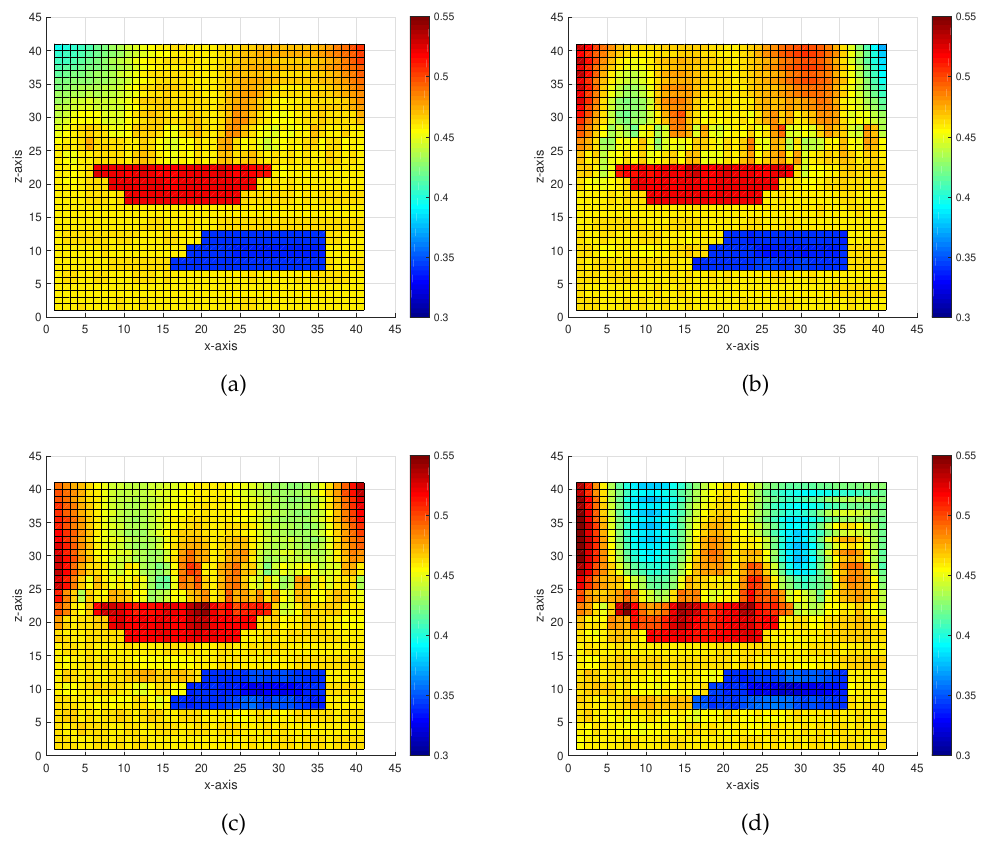
Figure 3. The true model.